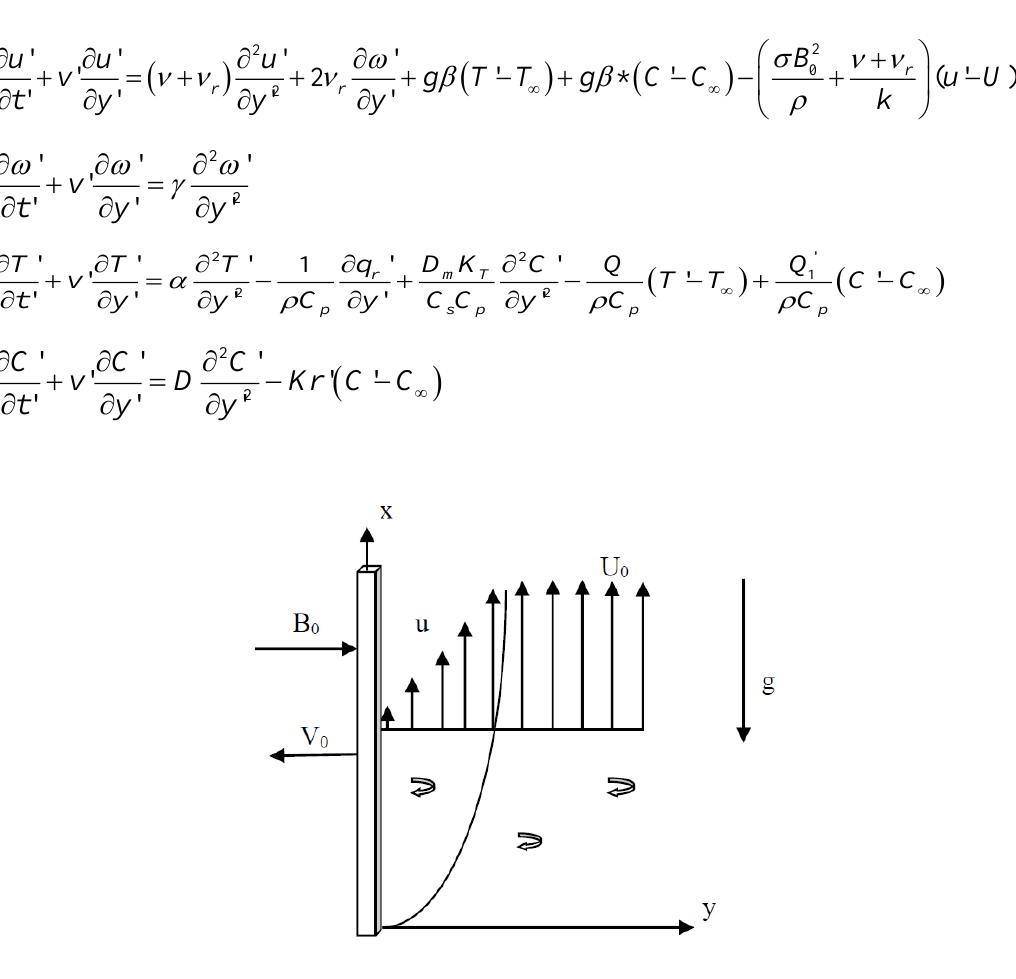
Figure 1. Physical description of the